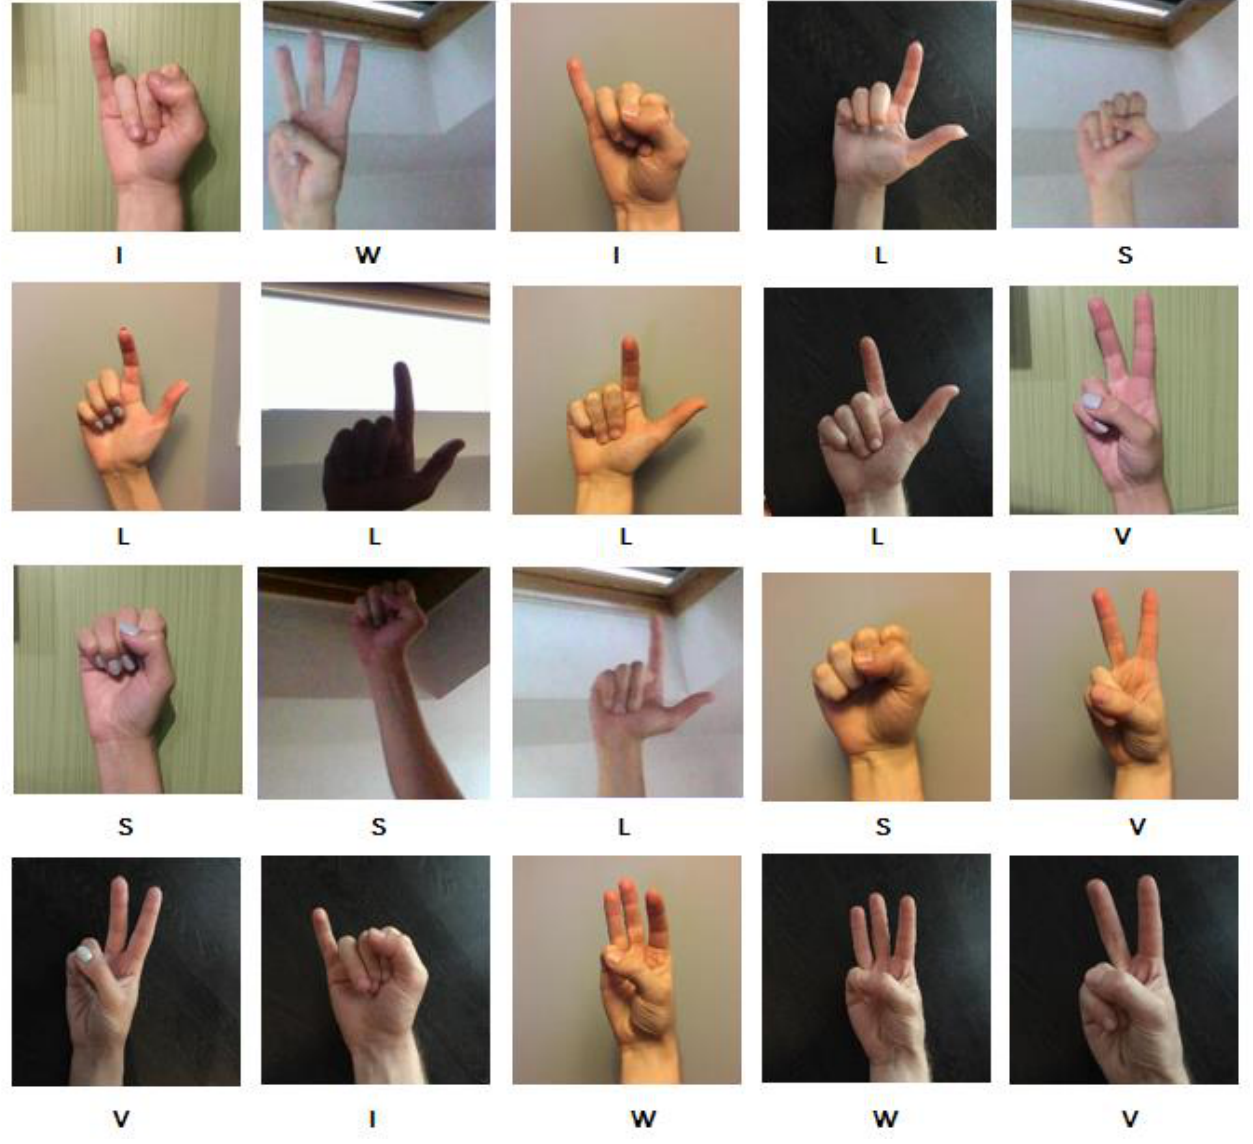
Figure 5. Part of the set of photos used for testing the application.